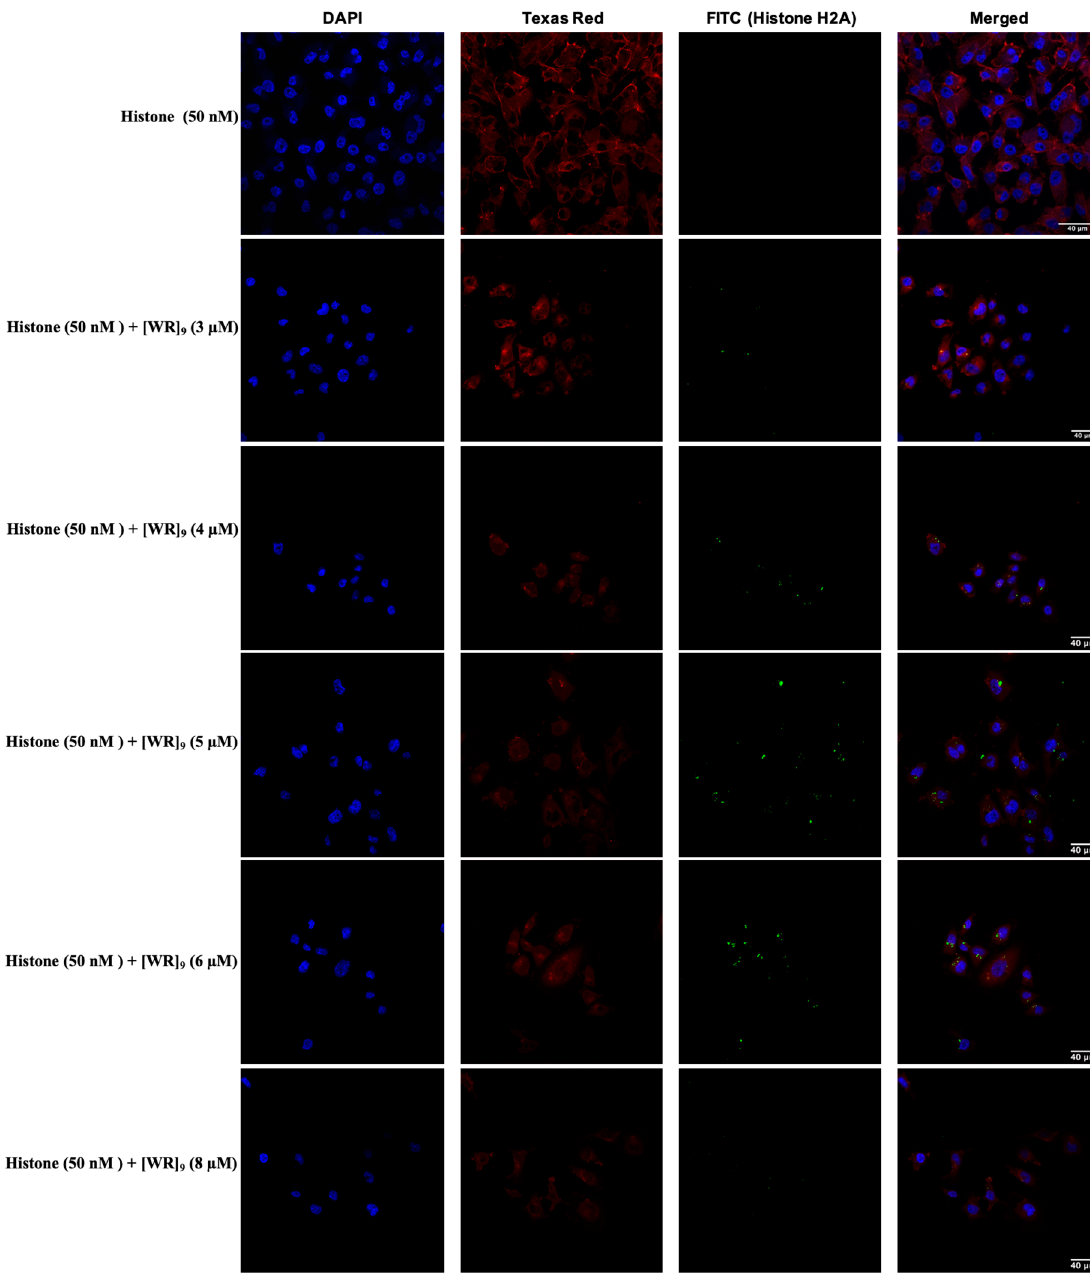
Figure 13. Confocal microscopy images of MDA-MB-231 cells incubated with the fluorescently labeled histone H2A-[WR] 9 mixture at a peptide concentration (3–8 µ M) and RFP at (50 nM) for 3 h. The blue, red, and green channels visualize DAPI (used to stain the nucleus), Texas Red (used to stain the cell membrane), and fluorescently labeled histone H2A, respectively.